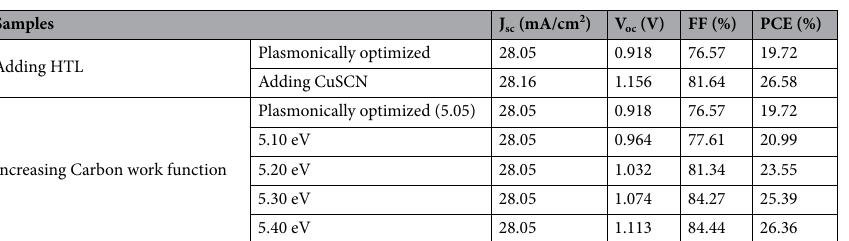
Table 3. Electrical characteristics of the optimized plasmonic simulated device with and w/o the CuSCN hole transport layer and as a function of carbon electrode work function.